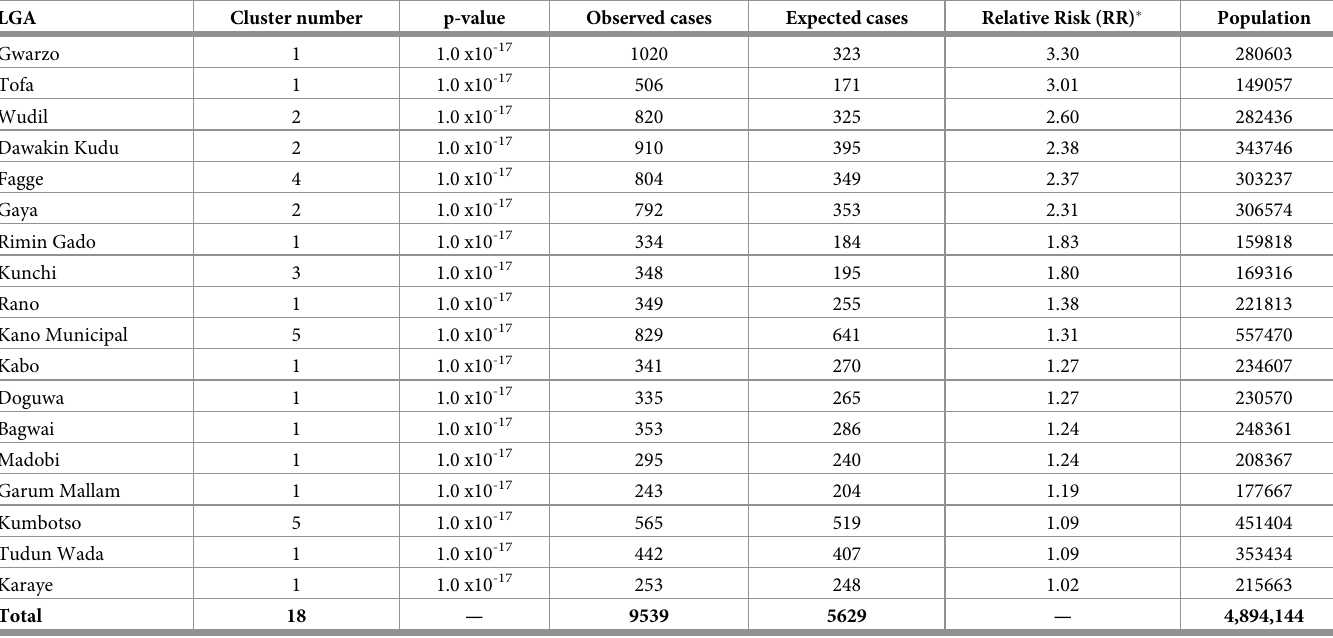
Table 2. Cholera hotspots classification based on statistical method (SaTScan).